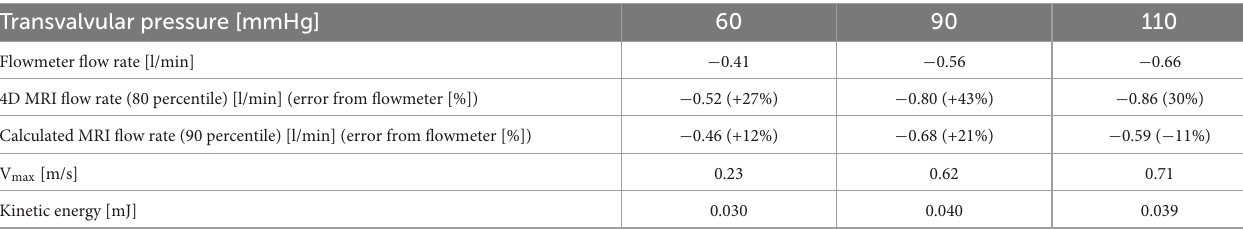
TABLE 6 Continuous regurgitation flow rates measured with the flowmeter and 4D magnetic resonance imaging (MRI) quantification using different percentile boundaries. Transvalvular pressure [mmHg] 60 90 110 Flowmeter flow rate [l/min] −